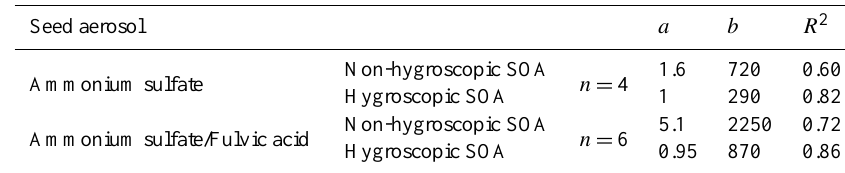
Table 5. Parameters of linear correlations of predicted vs. observed (Volkamer et al., 2009) SOA volumes (Fig. 4) for pure ammonium sulfate and ammonium sulfate/fulvic acid seed and different assumptions about SOA hygroscopicity. The model to predict SOA mass only includes OH(aq) + Gly(aq) reactions as applied to dilute aqueous conditions (cf Simualtion A in Sect. 3.3.1). V SOA (observed) a = a + b · [ V SOA model(OH reaction)]; correlation coefficients R 2 and number of experiments n .